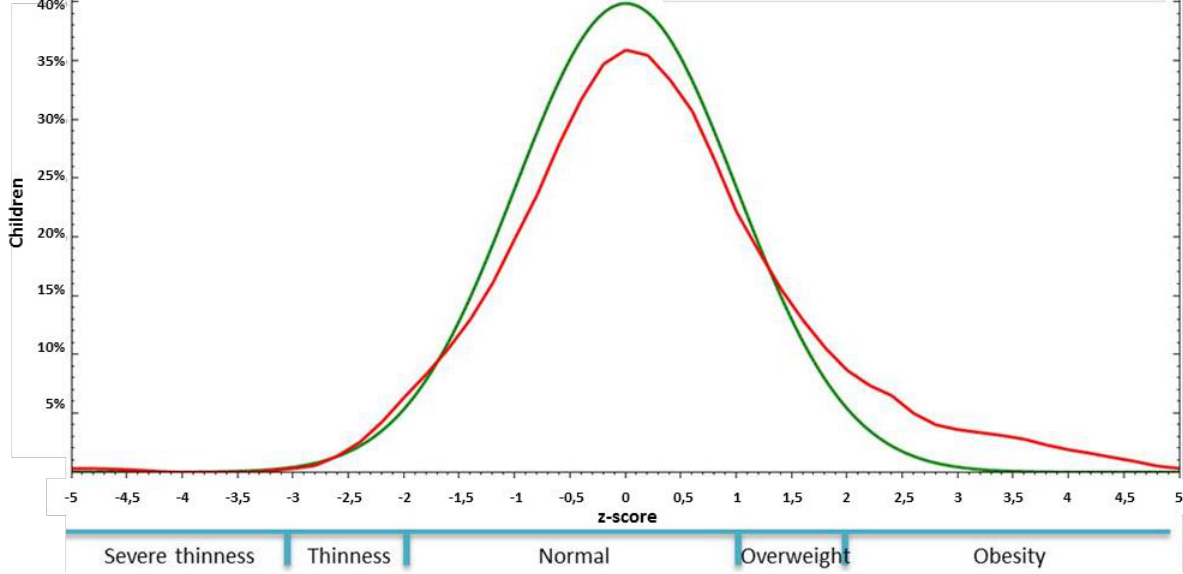
Figure 2. The Body Mass Index of children in the study. Data are shown as Z-scores (red line), and the WHO reference distribution (from 2007) for children 61 months to 19 years is also shown (green line).